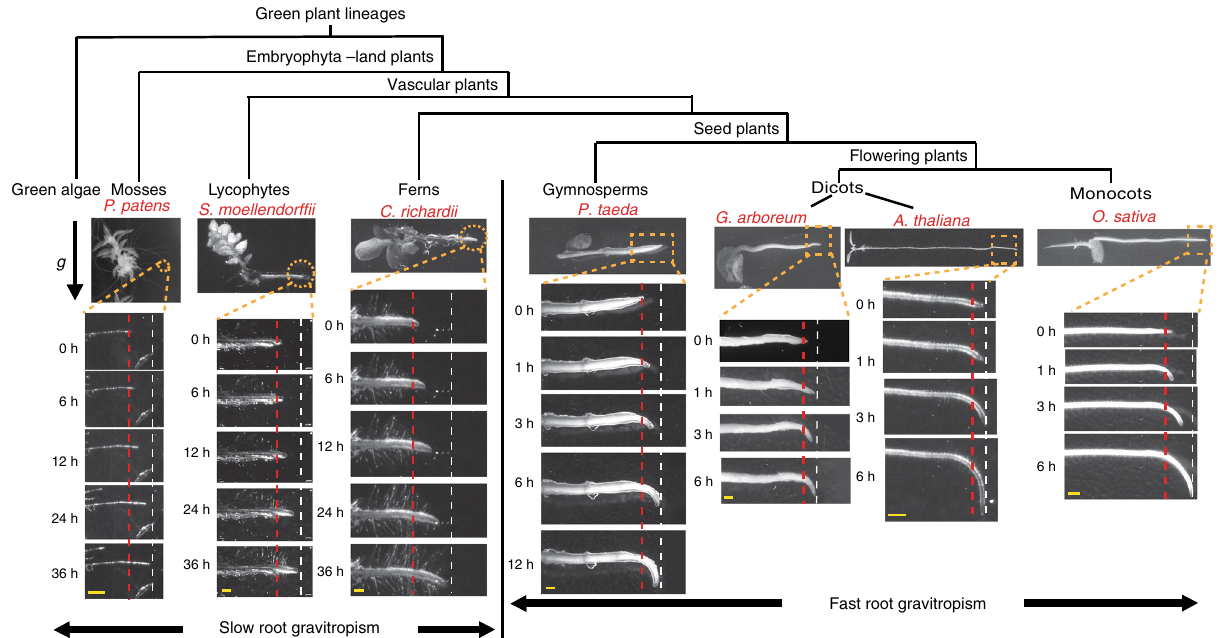
Fig. 1 Slow and fast mechanisms of root gravitropism during plant evolution. Slow gravitropic bending of the rhizoids of the moss P . patens , roots of the lycophyte S . moellendorf fi i , and the fern C . richardii after a 90° reorientation of the seedlings. Much faster response of the gymnosperm P . taeda , the dicots G . arboreum and A . thaliana , and the monocot O . sativa after gravistimulation. Scale bars, 1